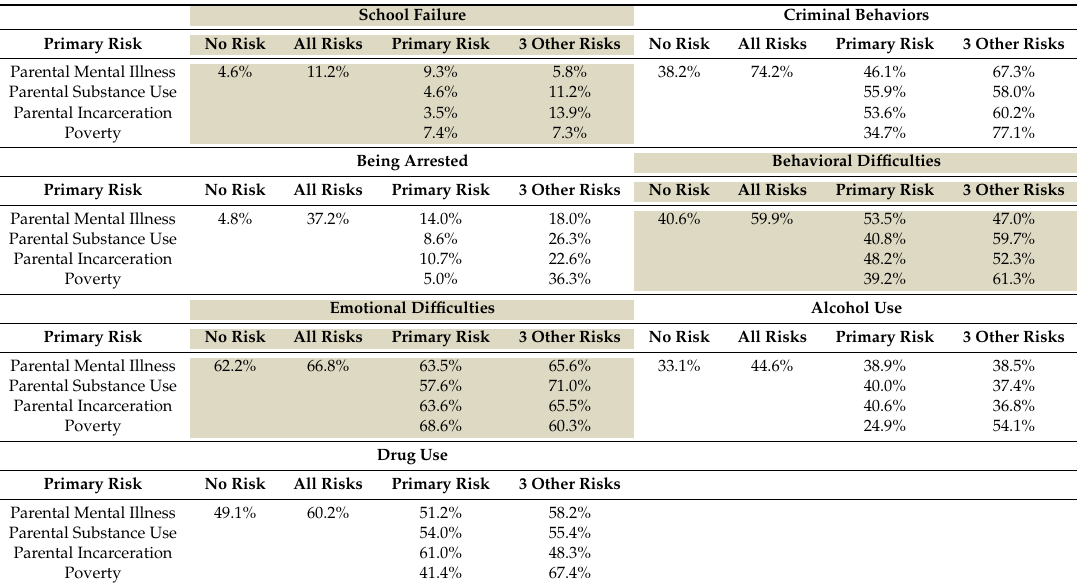
Table 5. Predicted Probabilities for Child